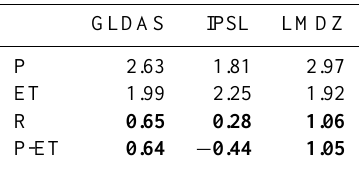
Table 1. Long-term annual means in mmd − 1 for precipitation (P), Evapotranspiration (ET), runoff (R) and P-ET from GLDAS, IPSL and LMDZ models during 1979-2005 averaged over the domain 70– 90 ◦ E; 10–28 ◦ N. The water balance is highlighted in